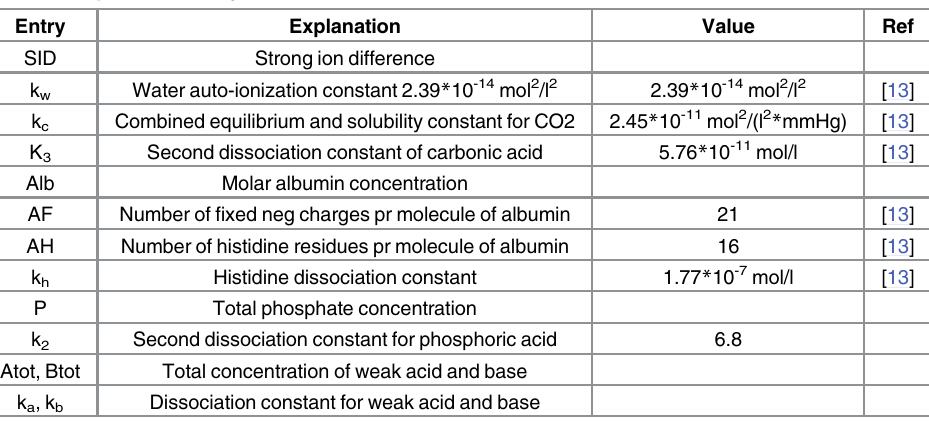
Table 1. Explanation for symbols and